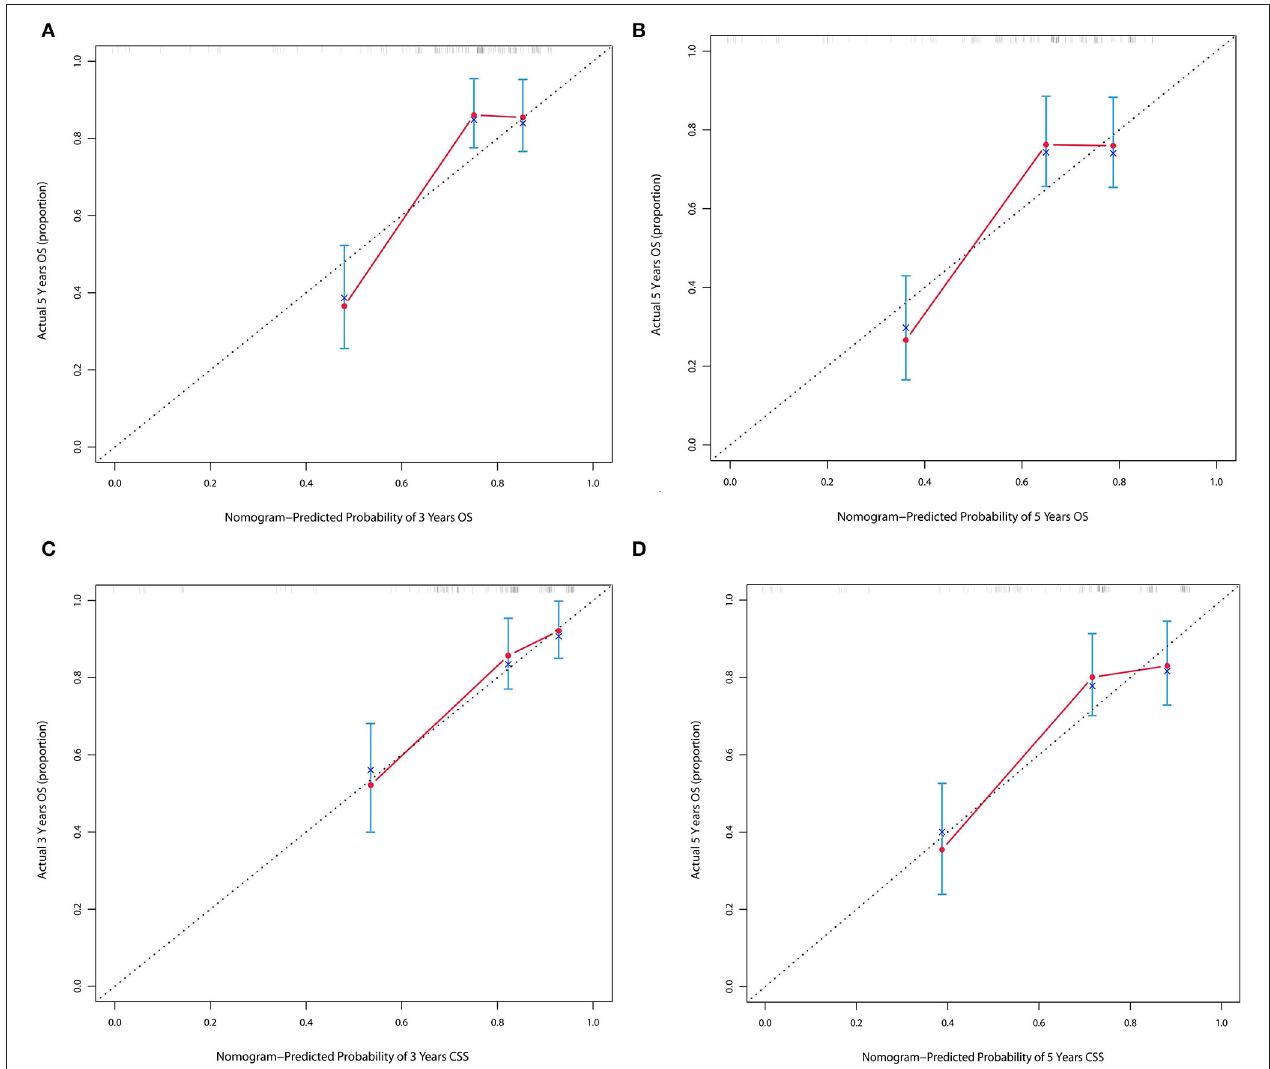
FIGURE 5 | (A,B) Calibration plot of nomograms in 3- and 5-years in the training cohort for OS. (C,D) Calibration plot of nomograms in 3- and 5-years in the training cohort for CSS. with model 2 (0.218) and model 3 (0.210). Among these models, model 1 yielded the highest AUC of 0.801 (95% CI